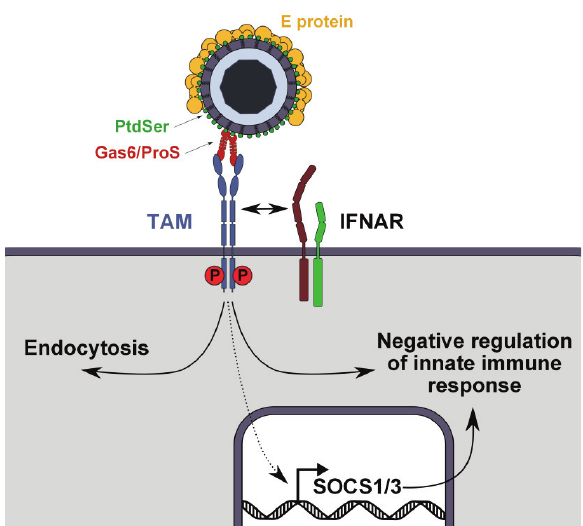
Figure 3. Dual role of TAM receptors during flavivirus infection. During entry, TAM receptors capture virus-Gas6/ProS complexes and enhance virus internalization through still unknown mechanisms. In parallel, virus-Gas6/ProS complexes activate TAM receptors, which recruit interferon receptor (IFNAR) to induce SOCS1/3 expression, thereby inhibiting innate antiviral responses and facilitating flavivirus